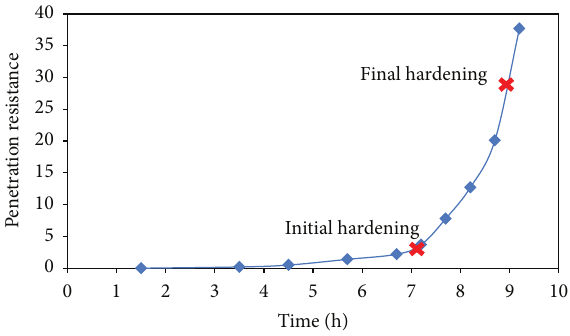
Figure 3: Penetration resistance curve for the concrete